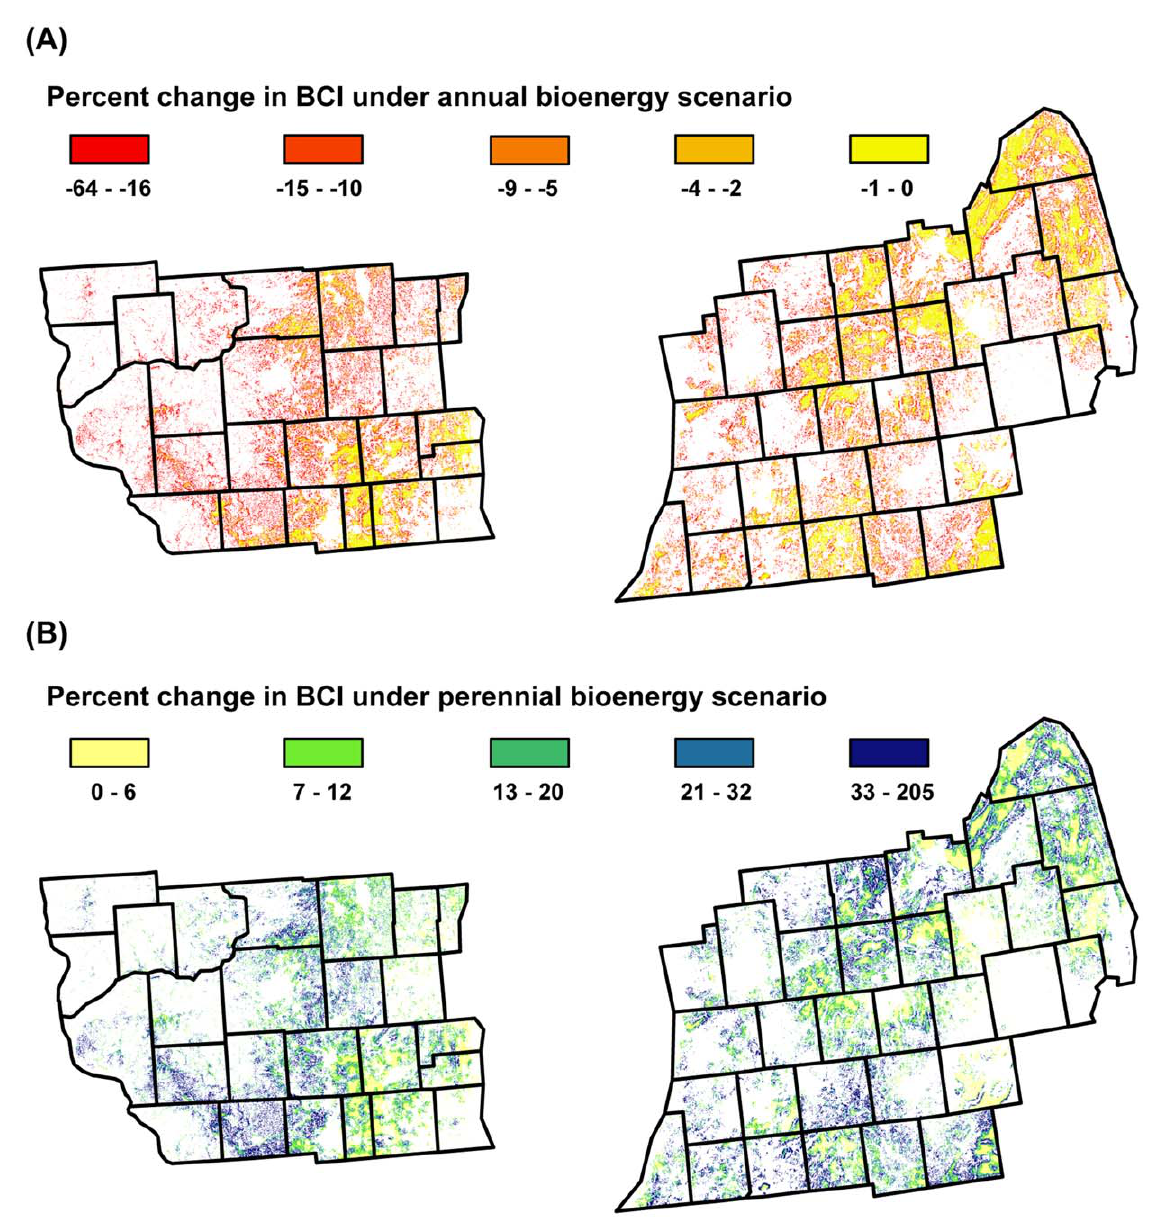
Figure 4. Change in projected biocontrol index. The percent change in the biocontrol index (BCI) between the current landscape configuration and that of two different bioenergy scenarios. The annual bioenergy scenario (A) assumes that existing grasslands on marginal soils are converted to annual bioenergy crops. The perennial bioenergy scenario (B) assumes that existing annual crops on marginal soils are converted to perennial bioenergy crops.